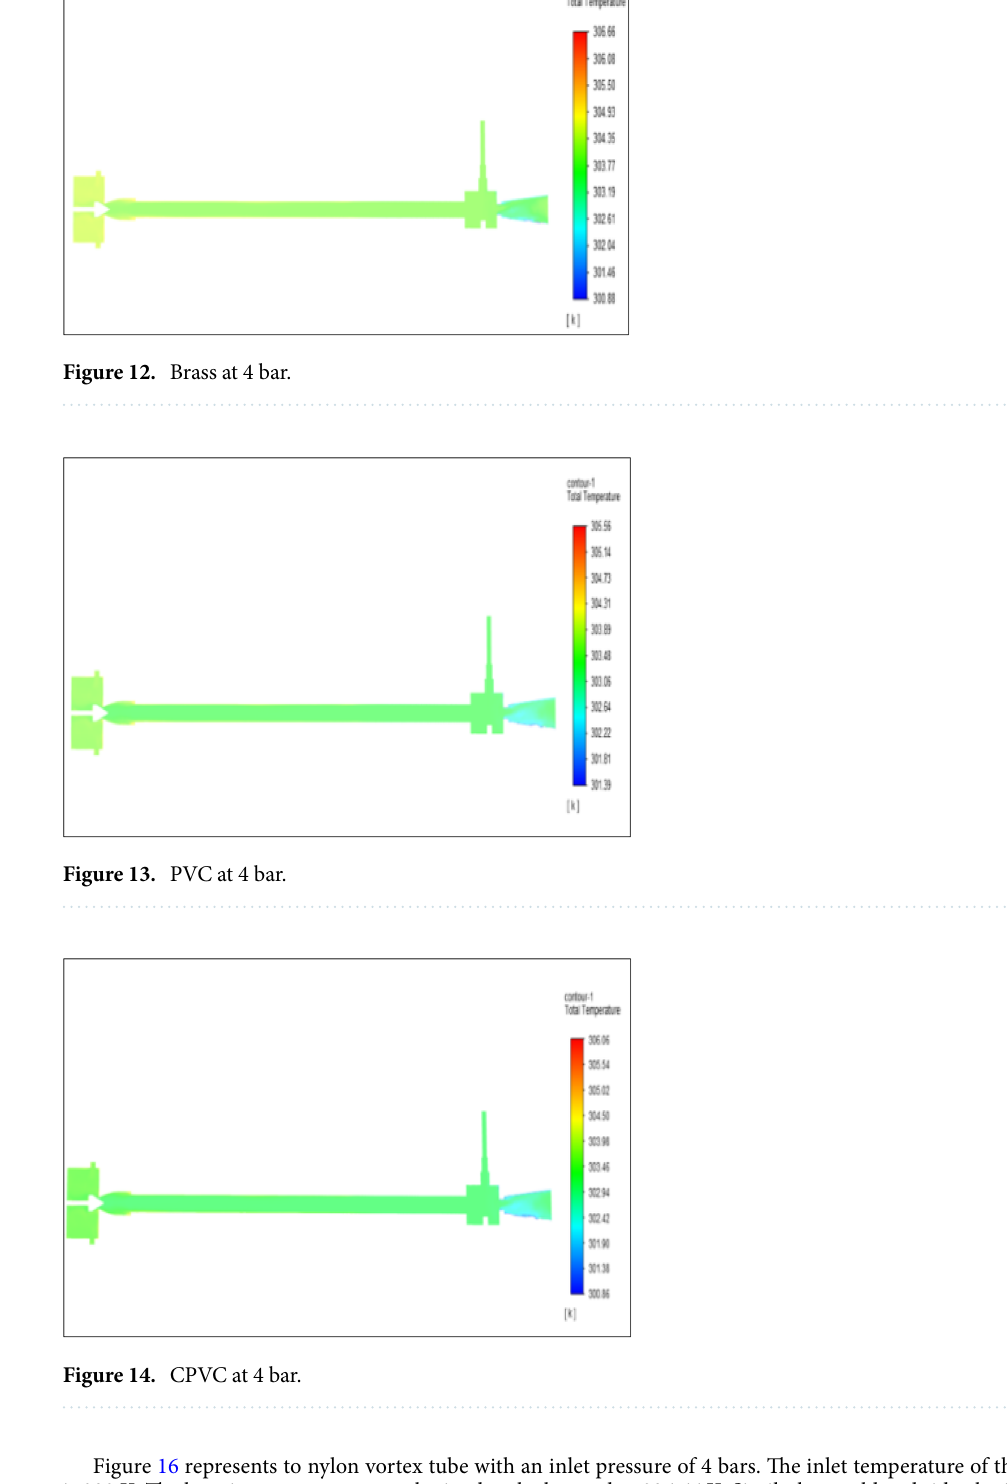
Figure 16 represents to nylon vortex tube with an inlet pressure of 4 bars. The inlet temperature of the VT is 303 K. The hot air temperature was obtained at the hot end as 306.66 K. Similarly at cold end side obtained a value of 301.8 K. The maximum temperature difference was found to be 4.86 K. Figure 17 represents to bronze vortex tube with an inlet pressure of 4 bars. The inlet temperature of the VT is 303 K. The hot air temperature was obtained at the hot end as 305.31 K. Similarly at cold end side obtained a value of 301.08 K. The maximum temperature difference was found to be 5.23 K.